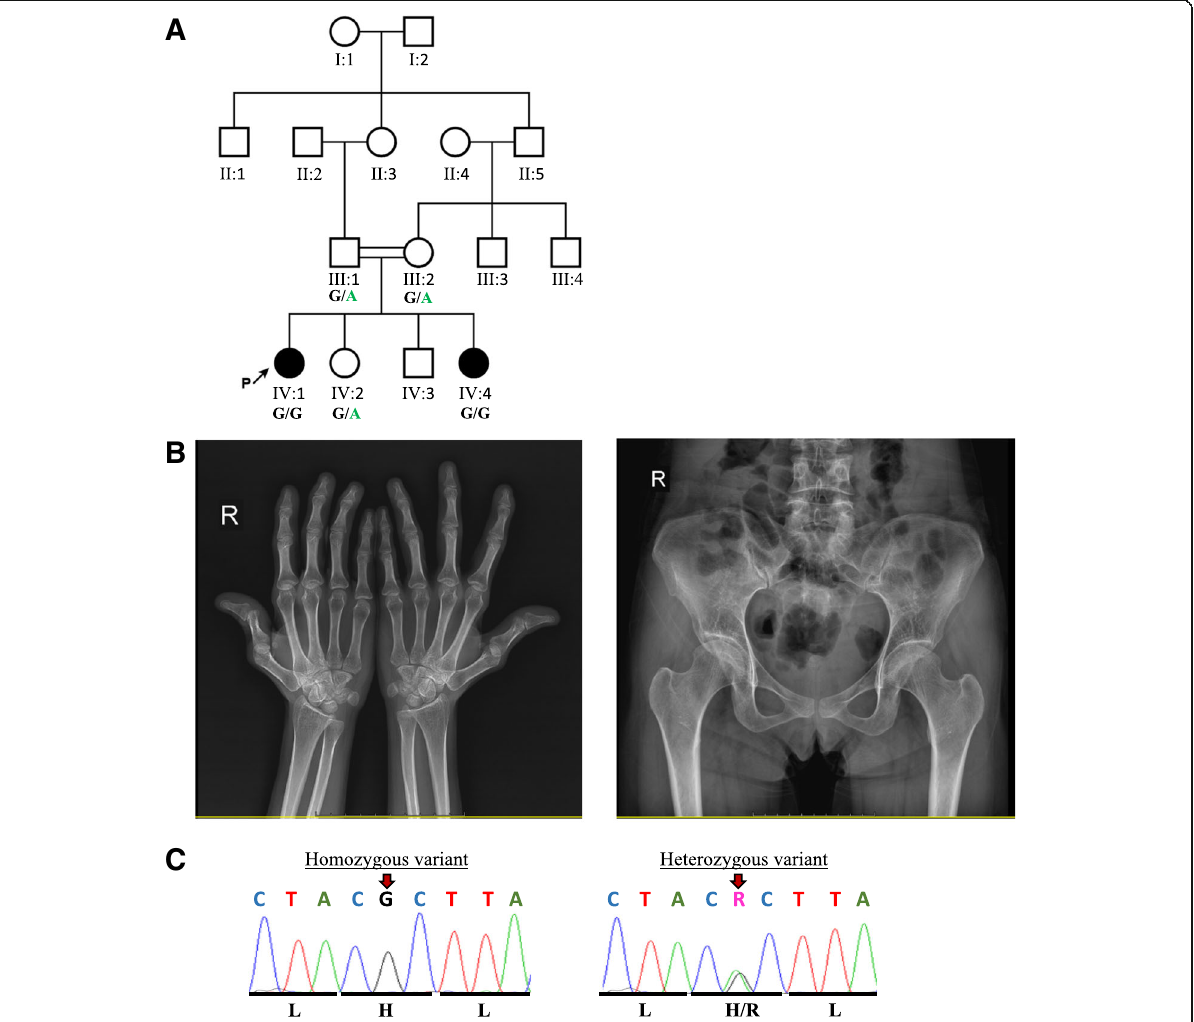
Fig. 2 Pedigree of patients 2 and 3, radiological examinations, and sequence electropherogram. a The proband ’ s parents are first-degree cousins. There is no family history of CAGSSS. Genotype results for the c.2282A> G variant are represented under the tested individuals. b Radiological images showing that the first metacarpale bone of the right hand (left) projects short and stunted and the plane x-ray the hyperextension of the metacarpophalangeal and the carpophalangeal joints of the thumb is noticeable. The carpal bones show some mild dysplasia and flattening and tapering of the distal phalanges is visible. Some mild dysplasia of the acetabulum is noticeable (right). On both sides a distinct cross over sign is visible. The femoral heads showing some irregular shape with flattened appearance known as pistol grip deformity. The femoral neck seems shortened in comparison to the opposite side. c Electropherograms of the homozygous proband (upper panel) and representative heterozygous electropherogram (lower panel) showing the nucleotide and amino acid exchange. The variant position is marked with a red